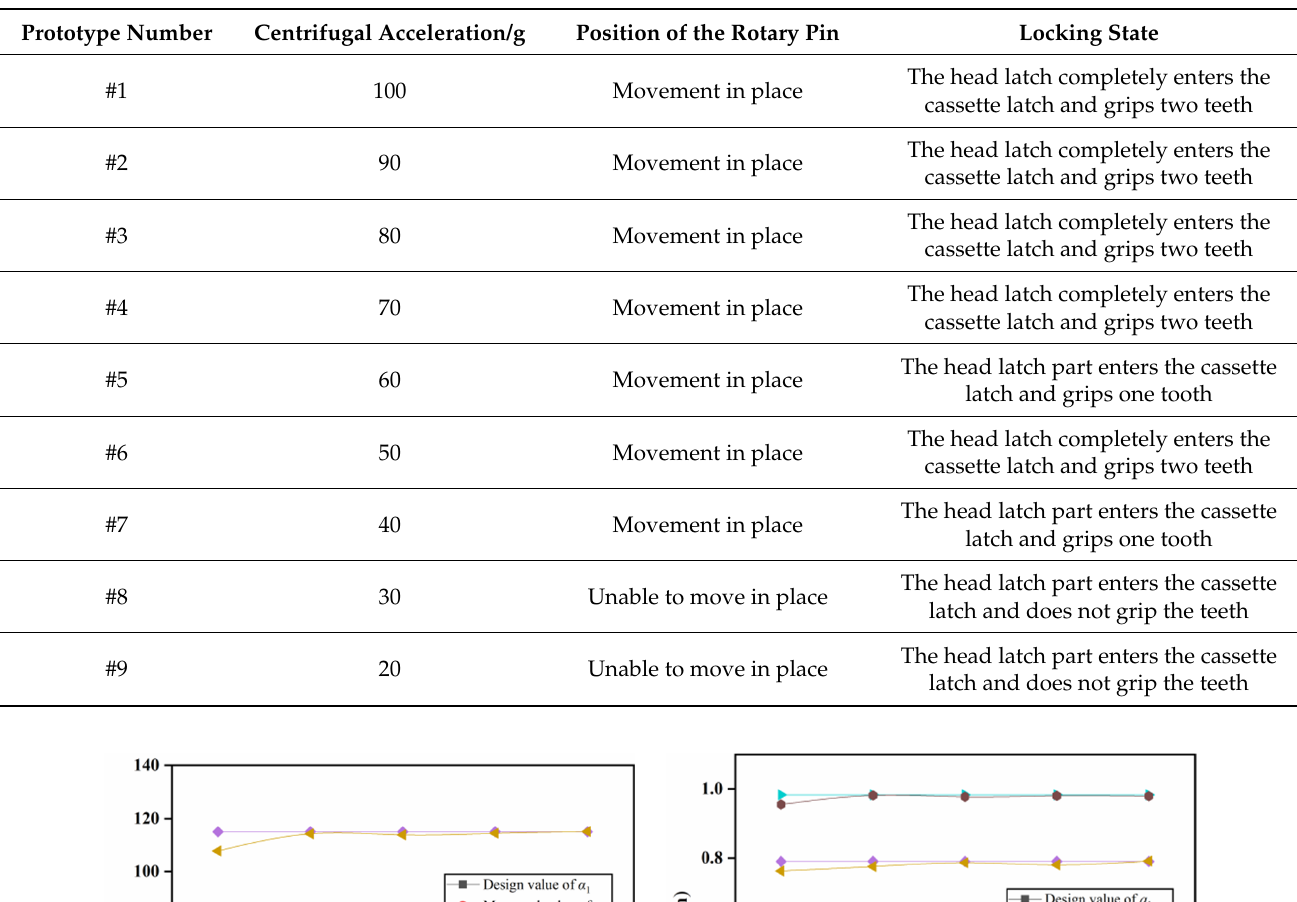
Table 5. Test results.